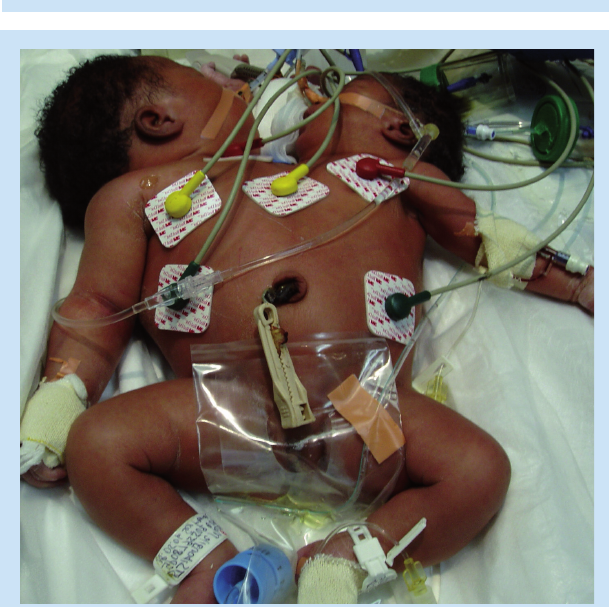
Fig 2. Day 2 post delivery photograph showing the larger twin A on the left, smaller twin B on the right, 2 heads, 2 necks, extra-large conjoined thorax, 2 sets of upper limbs, single female genitalia, and single set of lower